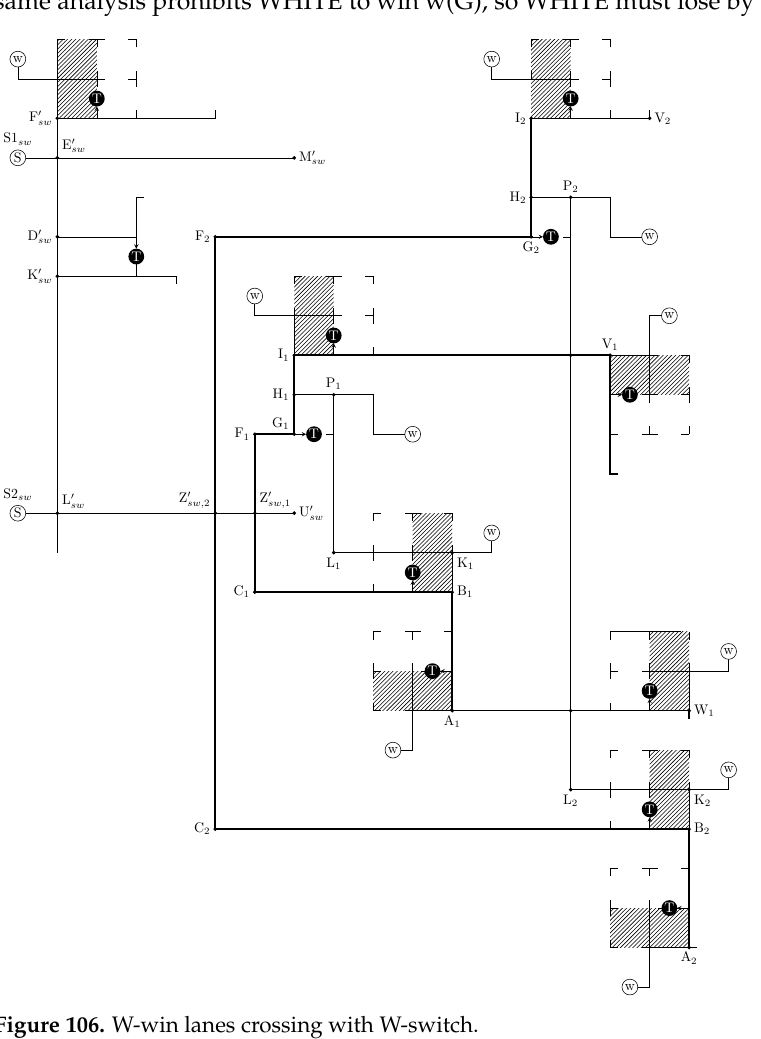
Figure 106. W-win lanes crossing with